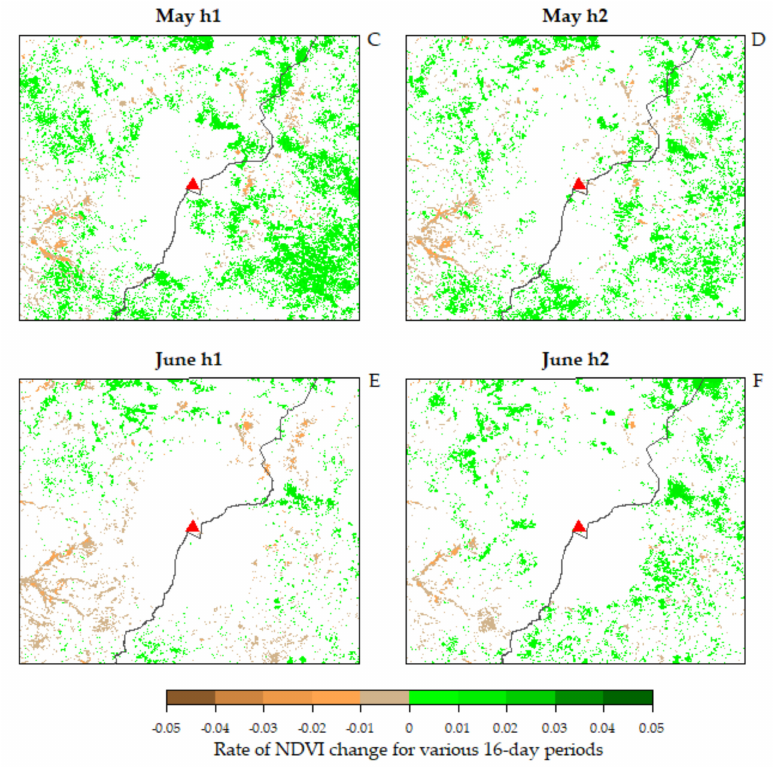
Figure 5. ( A – F ) Greening and browning trends in the Normalized Di ff erence Vegetation Index (NDVI) for every 16-day period in the months of April, May and June for 18 years